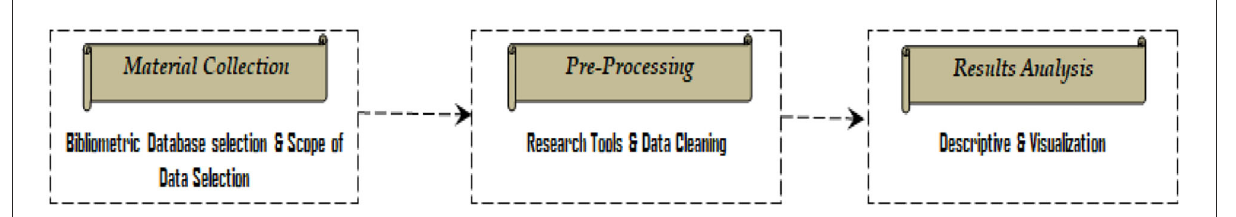
out that CiteSpace was updated to its latest version.